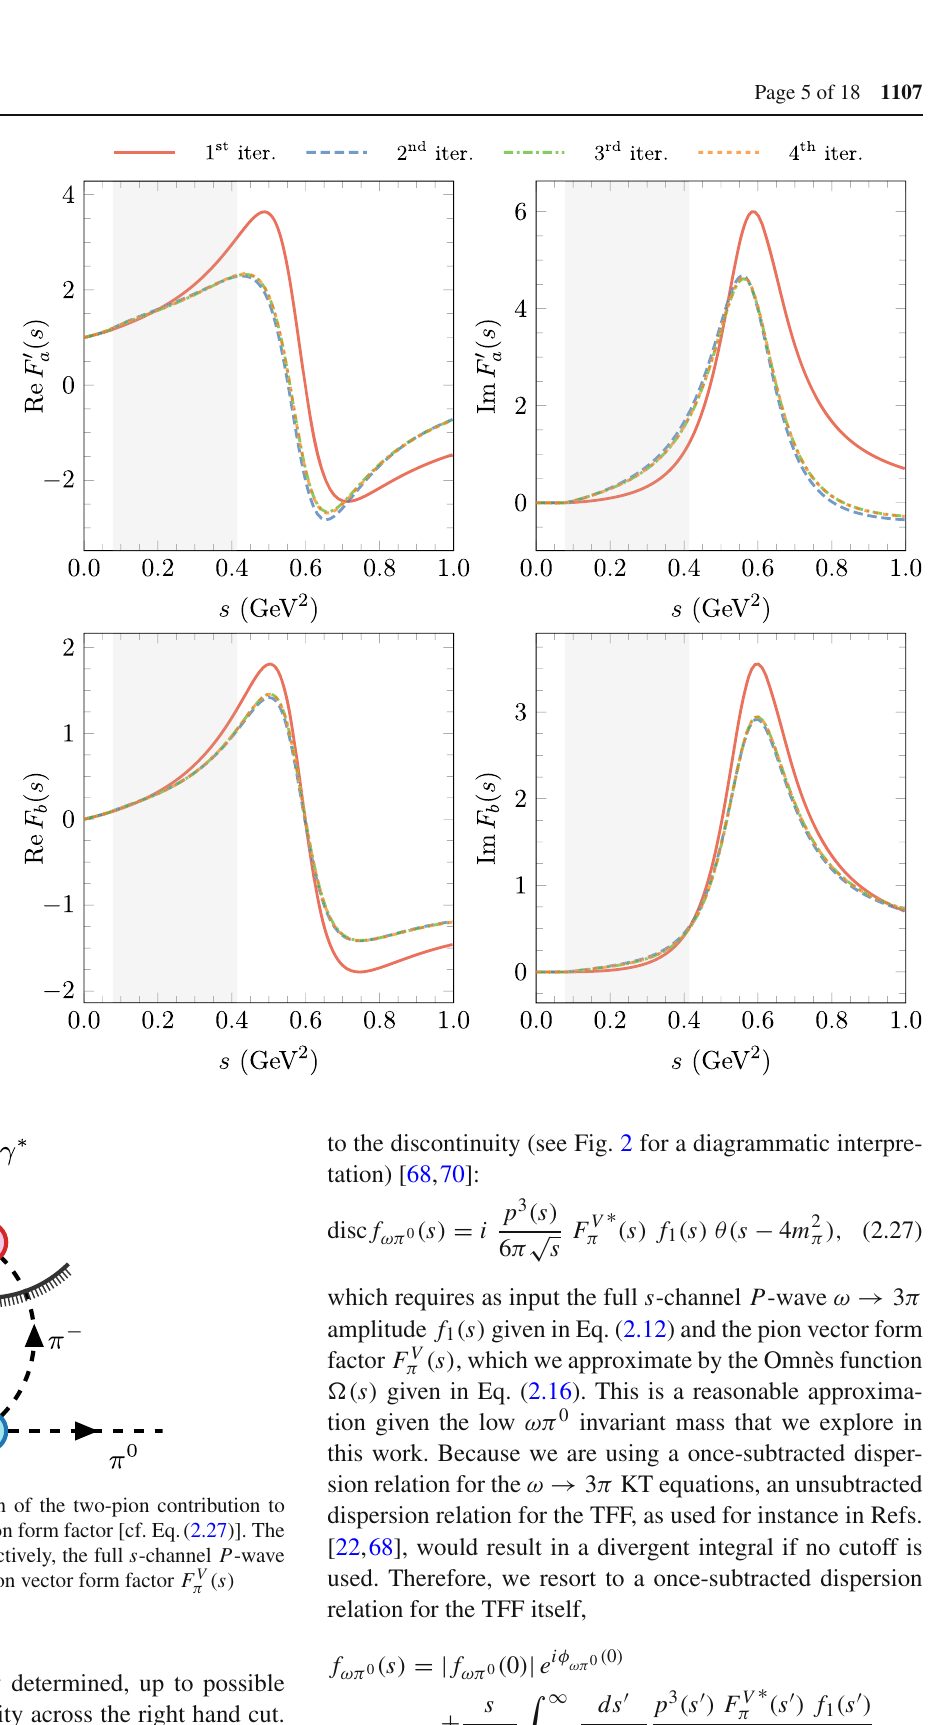
resentation of f ωπ 0 ( s ) is fully determined, up to possible subtractions, by the discontinuity across the right hand